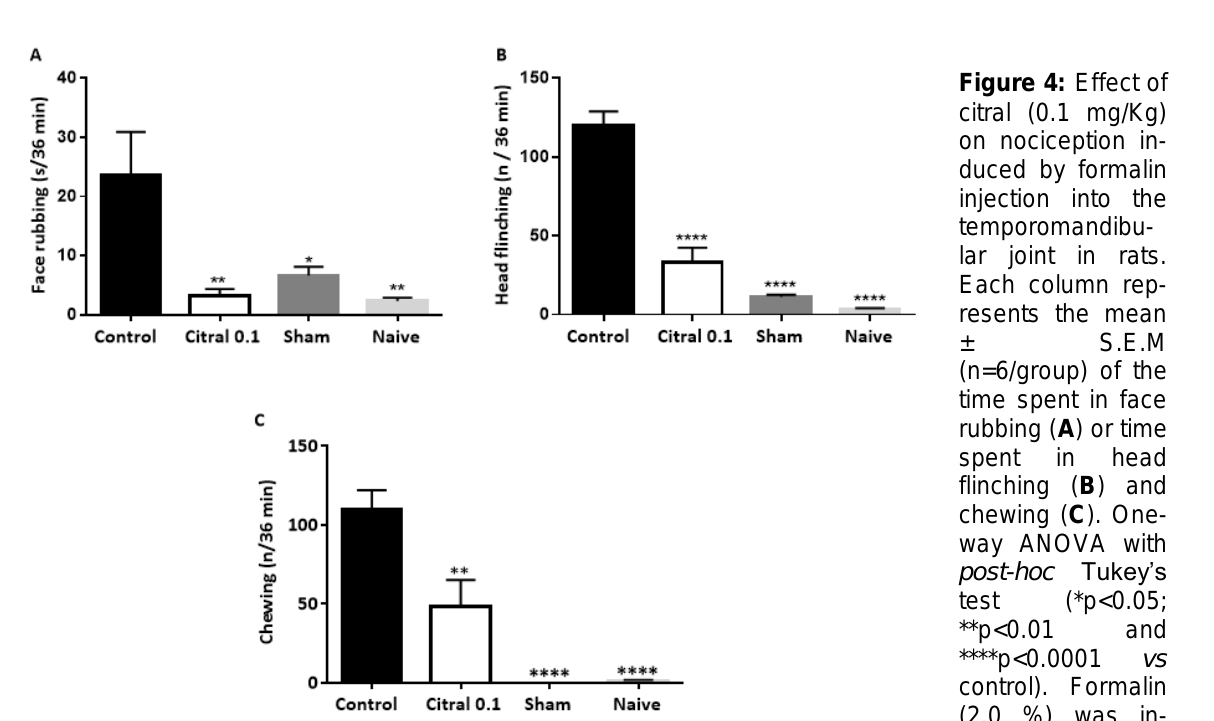
Figure 4: Effect of citral (0.1 mg/Kg)